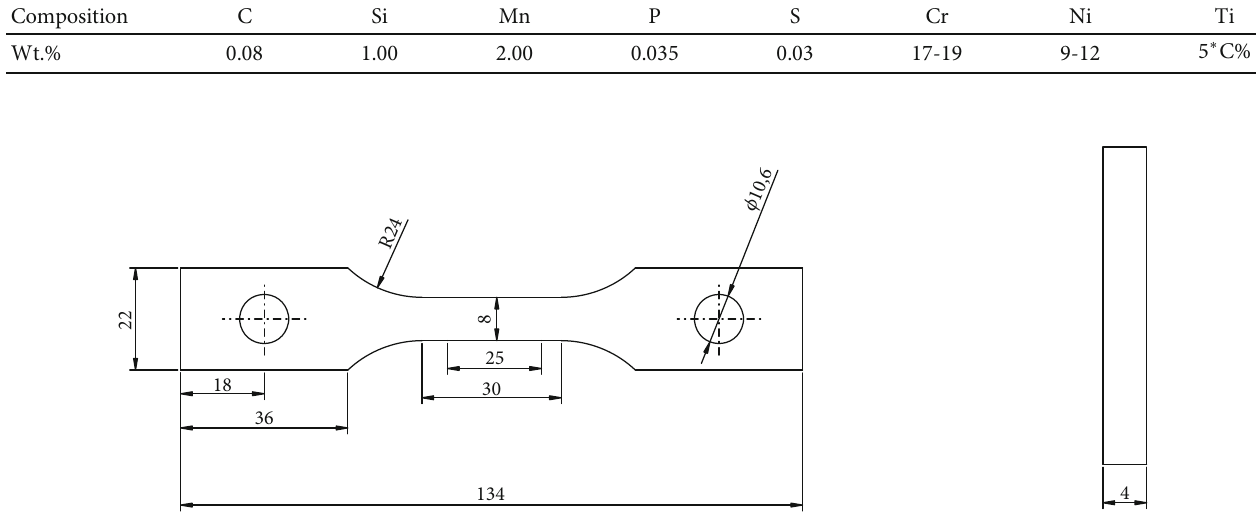
Figure 2: Geometry of tensile specimen. The specimen was machined to a thickness of 4mm.